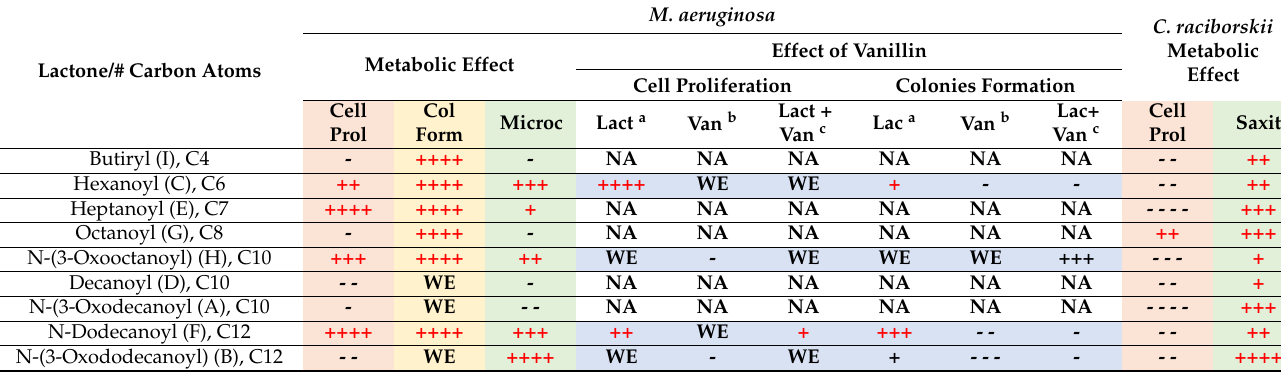
Table 1. General effects of several lactones in Microcystis aeruginosa and Cylindrospermopsis raciborskii .